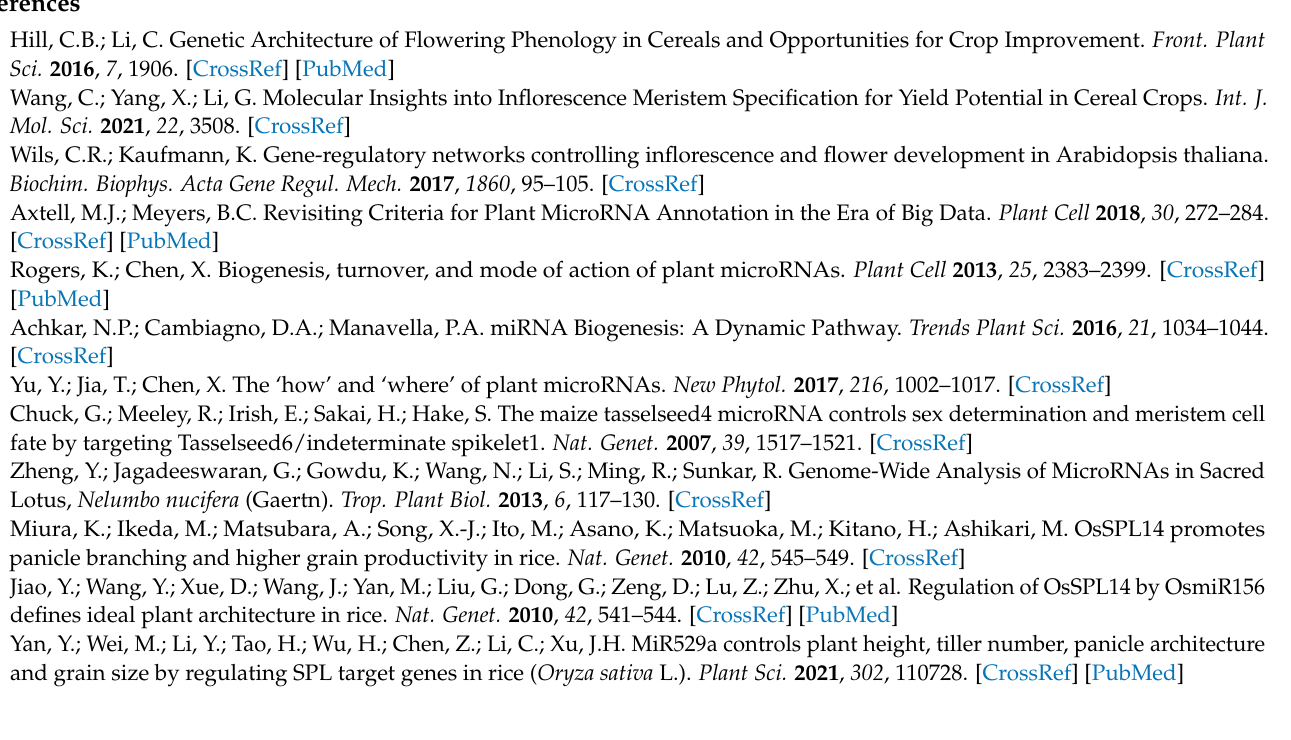
development, Figure S2: Heatmap of differential gene expression, Figure S3: Molecular phylogeny of proteins encoded by the differentially expressed oil palm SPL genes; Table S1: List of miRNA genes identified, Table S2: Accumulation profiles of mature miRNAs, Table S3: List of differentially expressed genes (DEGs), Table S4: List of DEGs in each identified functional category, Table S5: Summary of gene enrichment data, Table S6: Hormone analysis data, Table S7: Illumina/mapping summary—small RNA and